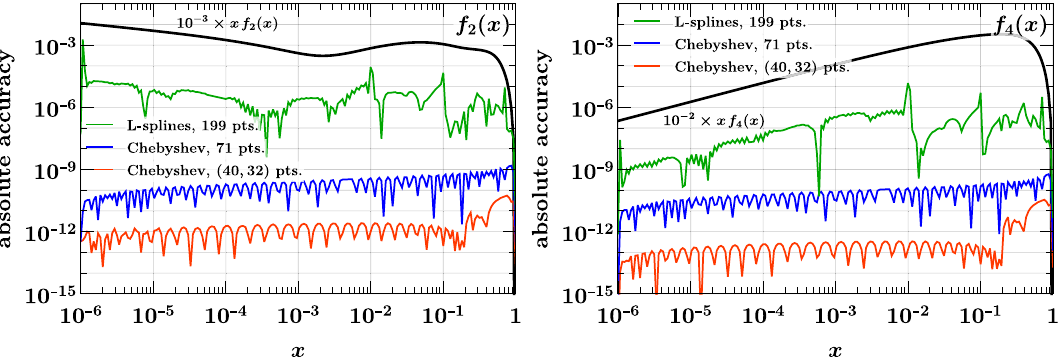
Fig. 4 As Fig. 3, but showing the absolute instead of relative interpolation accuracy for x f ( x ) , i.e. the absolute difference between the interpolated and exact